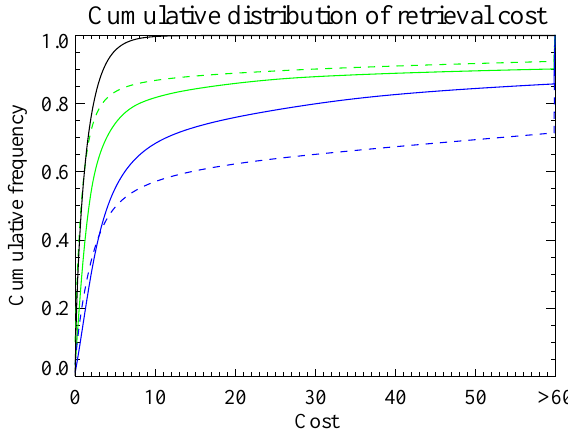
Fig. 1. Cumulative frequency distributions of retrieval costs. Solid lines indicate water cloud and dashed ice; green lines indicate cloud over land, and blue over sea. The solid black line corresponds to a theoretical χ 2 distribution with 1.4 degrees of freedom.